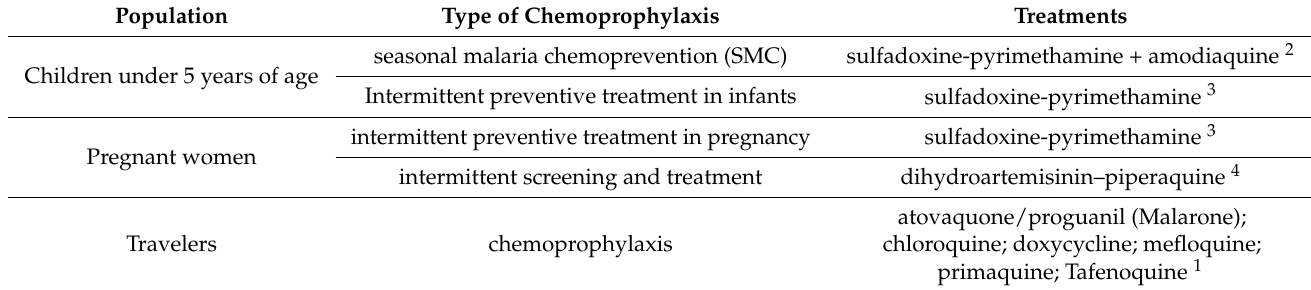
Table 3. Chemoprophylactic regimens for malaria. 1 Treatments recommended by the Centers for Disease Control and Prevention (CDC); 2 Previously (before the 2012 WHO recommendation) named Intermittent Preventive Treatment in children, or IPTc; 3 Recommended by the WHO; 4 Recommended by the WHO; 4